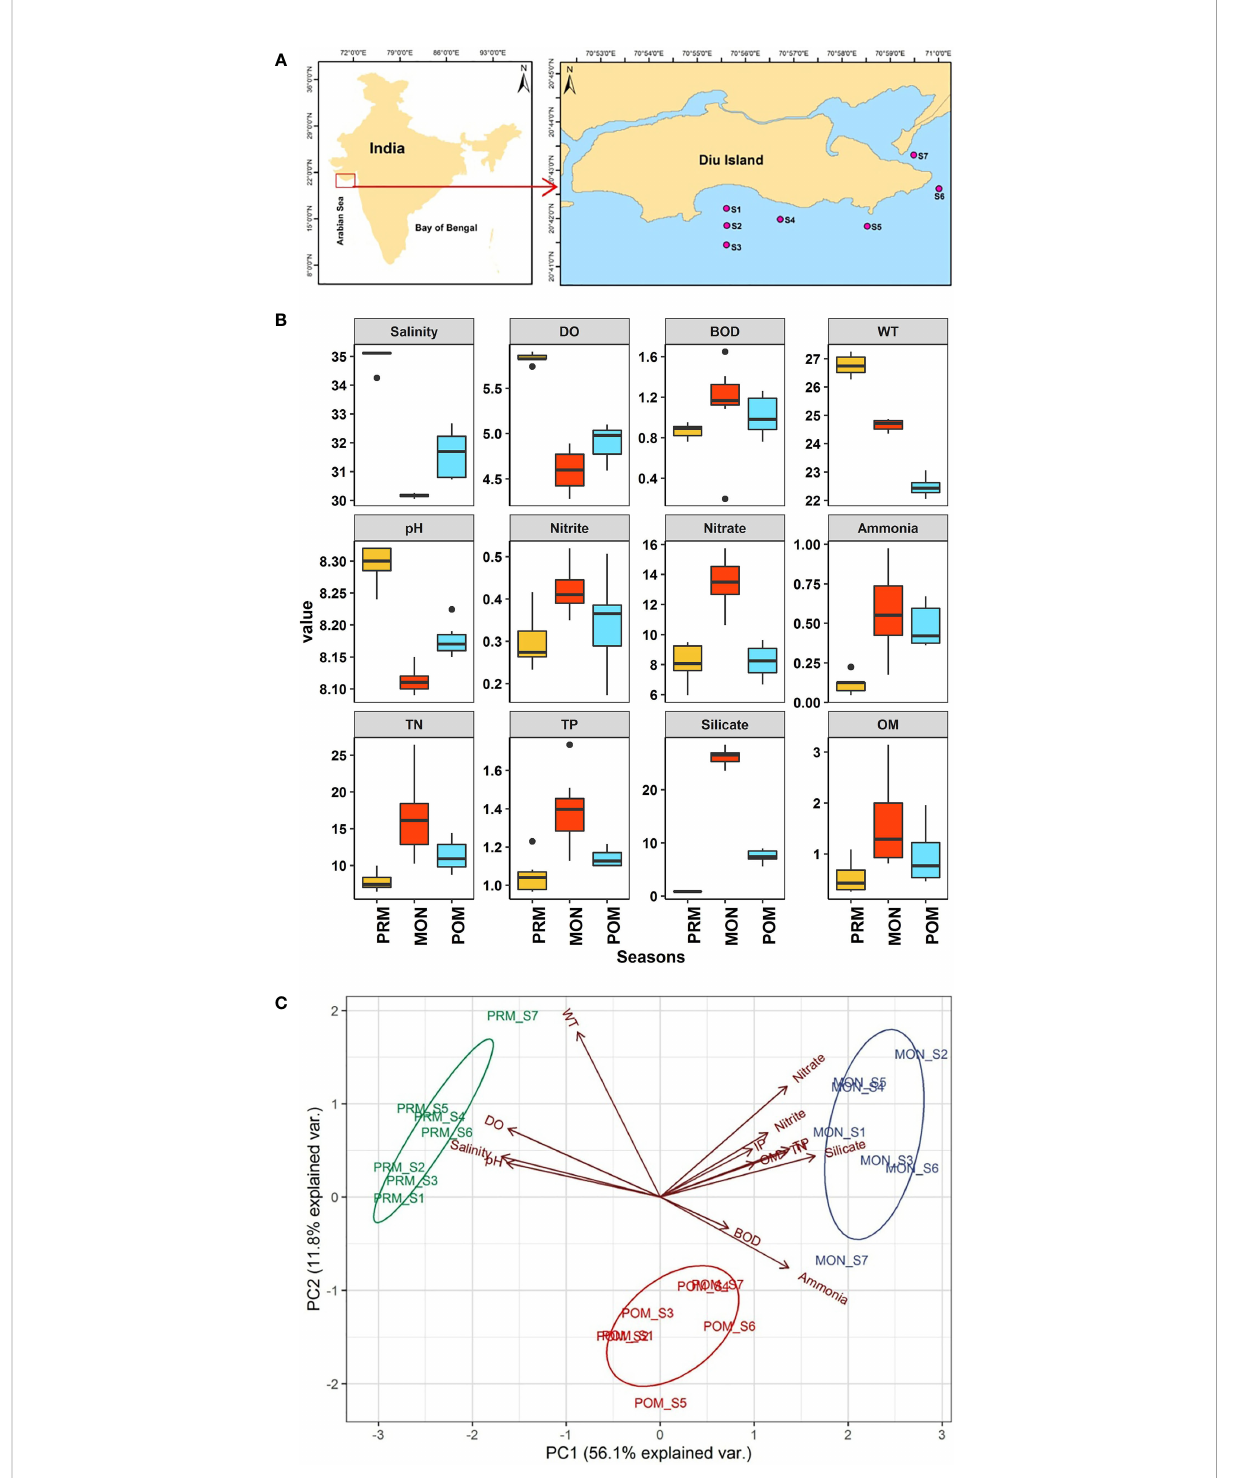
FIGURE 1 (A) Study area map, red points in enlarged map show the sampling stations along the coastal region of Diu island, (B) Box plots showing the variations in physicochemical parameters during different seasons. The central line of each boxes represents the median, the rectangle gives the interval between 25% and 75% percentiles, whiskers indicate the range and black dots represent outliers. Y- axis represents the value of each parameter namely DO and BOD are in mg/L, Salinity (PSU), WT (°C) and OM in %, whereas Ammonia, IP, Nitrate, Nitrite, Silicate, TN and TP are in µL/L. X-axis represents different seasons, (C) PCA biplot illustrating the variability in the environmental parameters between three